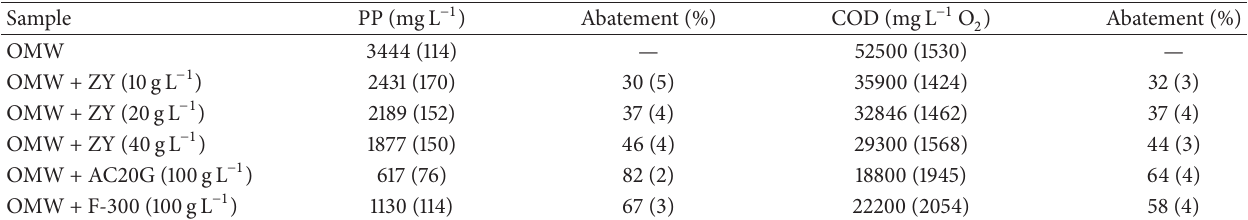
Table 2: PP and COD values in OMW before and after adsorption onto ZY and activated carbons ( 𝑛 = 3 ). Sample